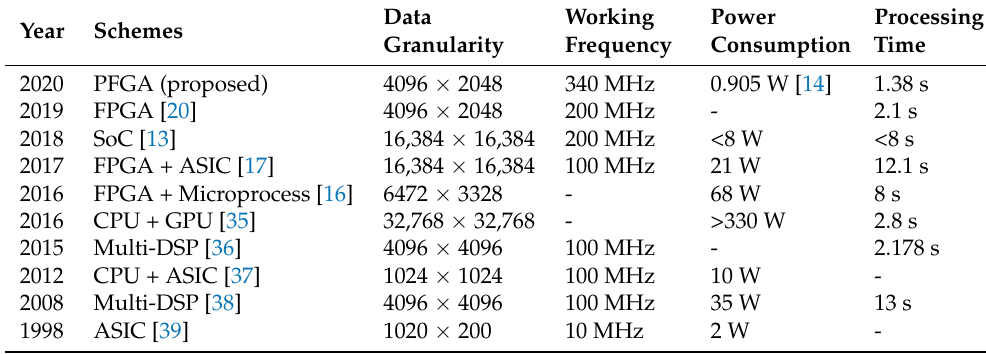
Table 5. Comparison with Previous